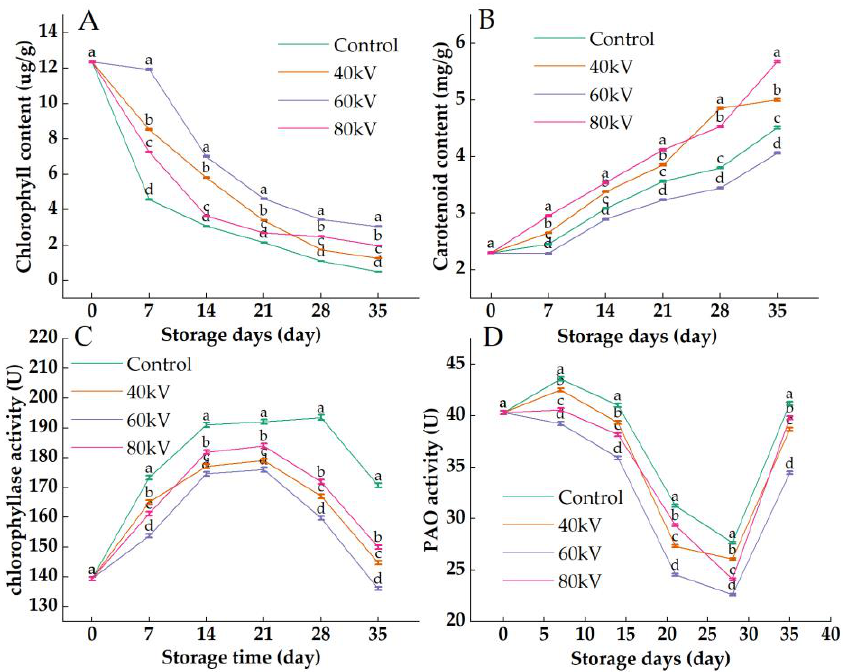
Figure 3. Effects of different intensities of ACP treatment on the chlorophyll content, carotenoid content, chlorophyllase content, and pheophorbide a mono-oxygenase content in tomato: ( A ) chlorophyll content; ( B ) carotenoid content; ( C ) chlorophyllase activity; ( D ) pheophorbide a mono-oxygenase activity. Bars labeled with different small letters (a – d) indicate significant differences among different ACP treatments at the same storage time ( p ≤ 0.05).